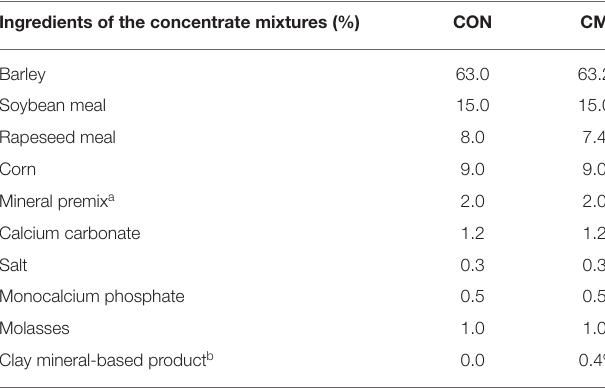
TABLE 1 | Ingredients of the concentrate mixtures for the control cows (CON) and the clay mineral-based feed additive-supplemented cows (CM). Ingredients of the concentrate mixtures